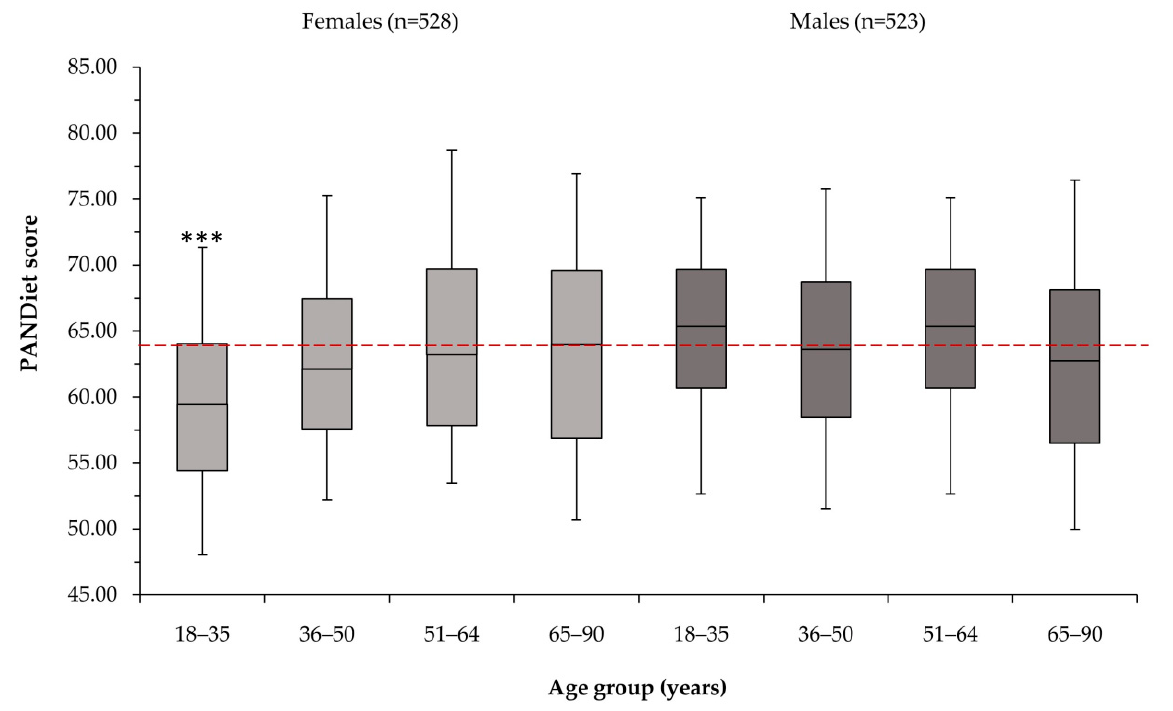
Figure 2. PANDiet scores by gender and age group. Horizontal dashed line indicates population median PANDiet score (63.69). Values shown as median, 50% interquartile range, and whiskers as 5 and 95% confidence intervals. *** significantly different at the <0.001 level, assessed using ANCOVA with Bonferroni post-hoc corrections for multiple comparisons.